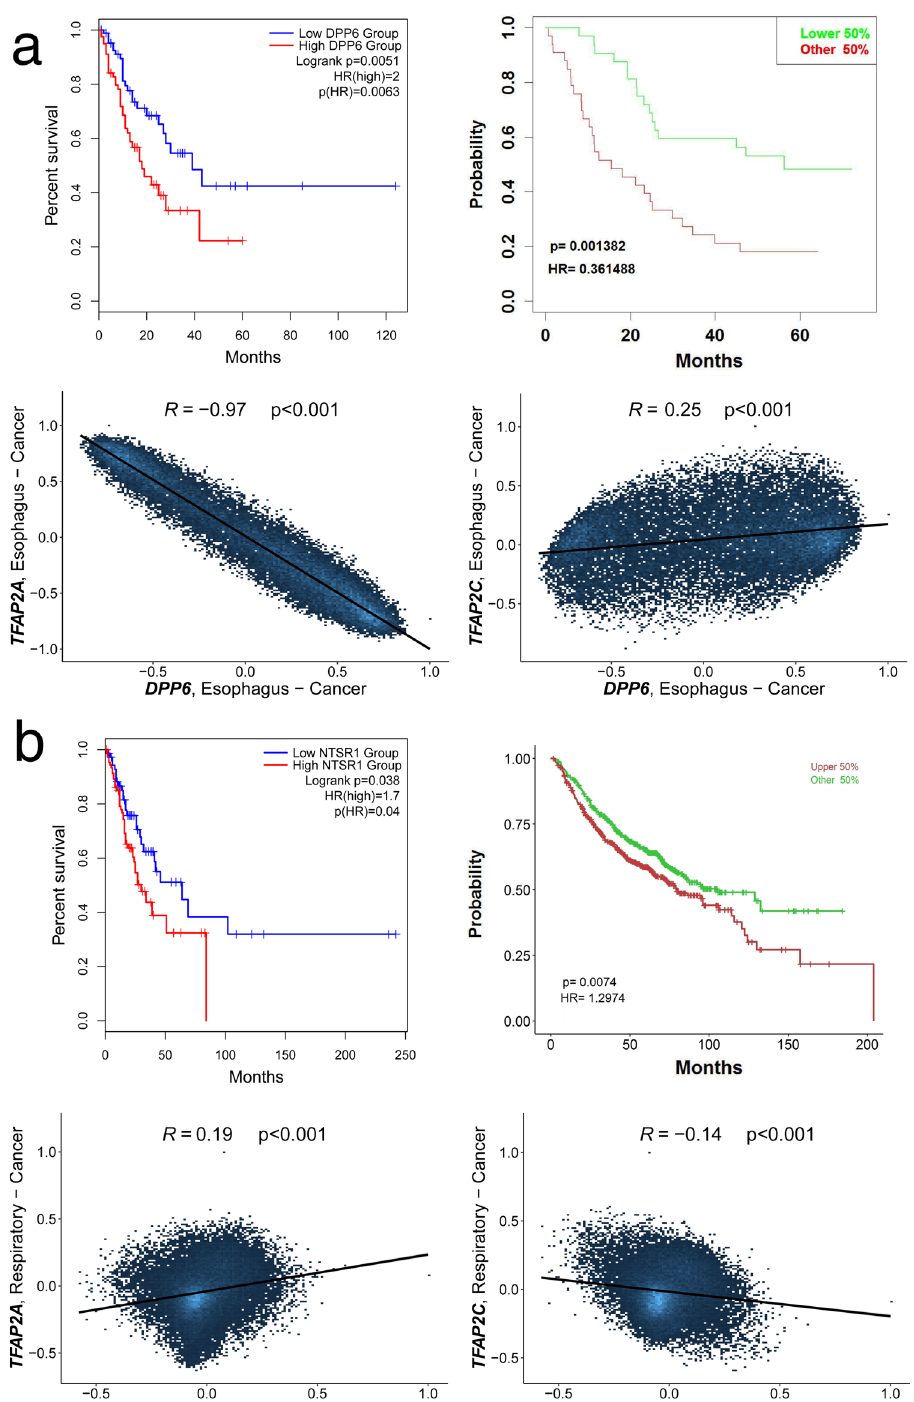
Figure 6. Differently regulated mutual targets. ( a ) DPP6 . ( b ) NTSR1